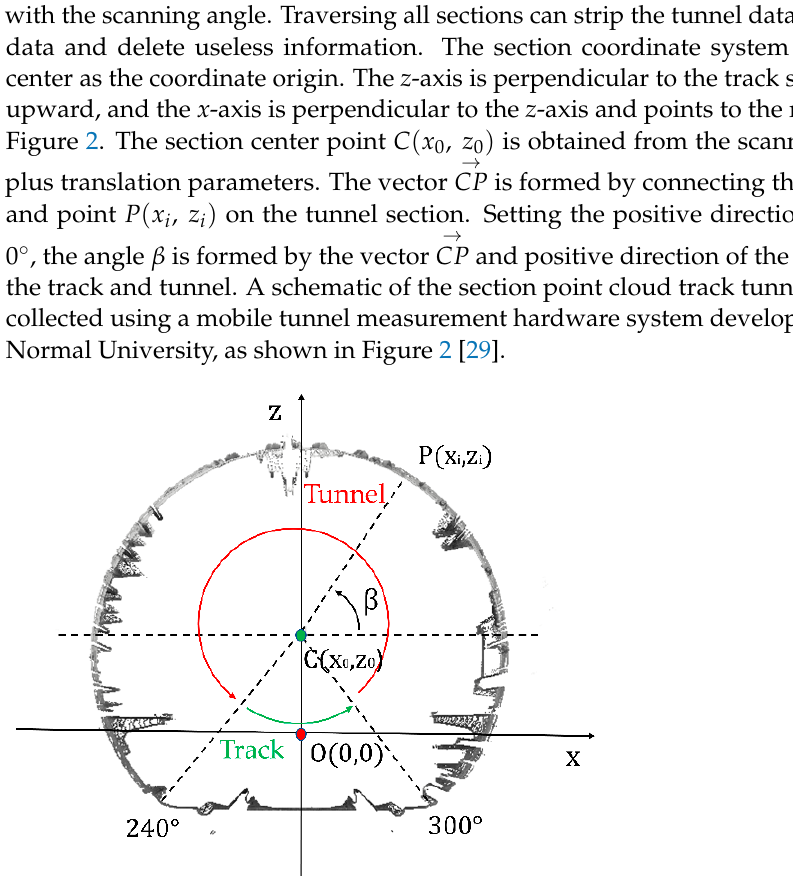
Figure 2. Schematic of the track and tunnel separation.